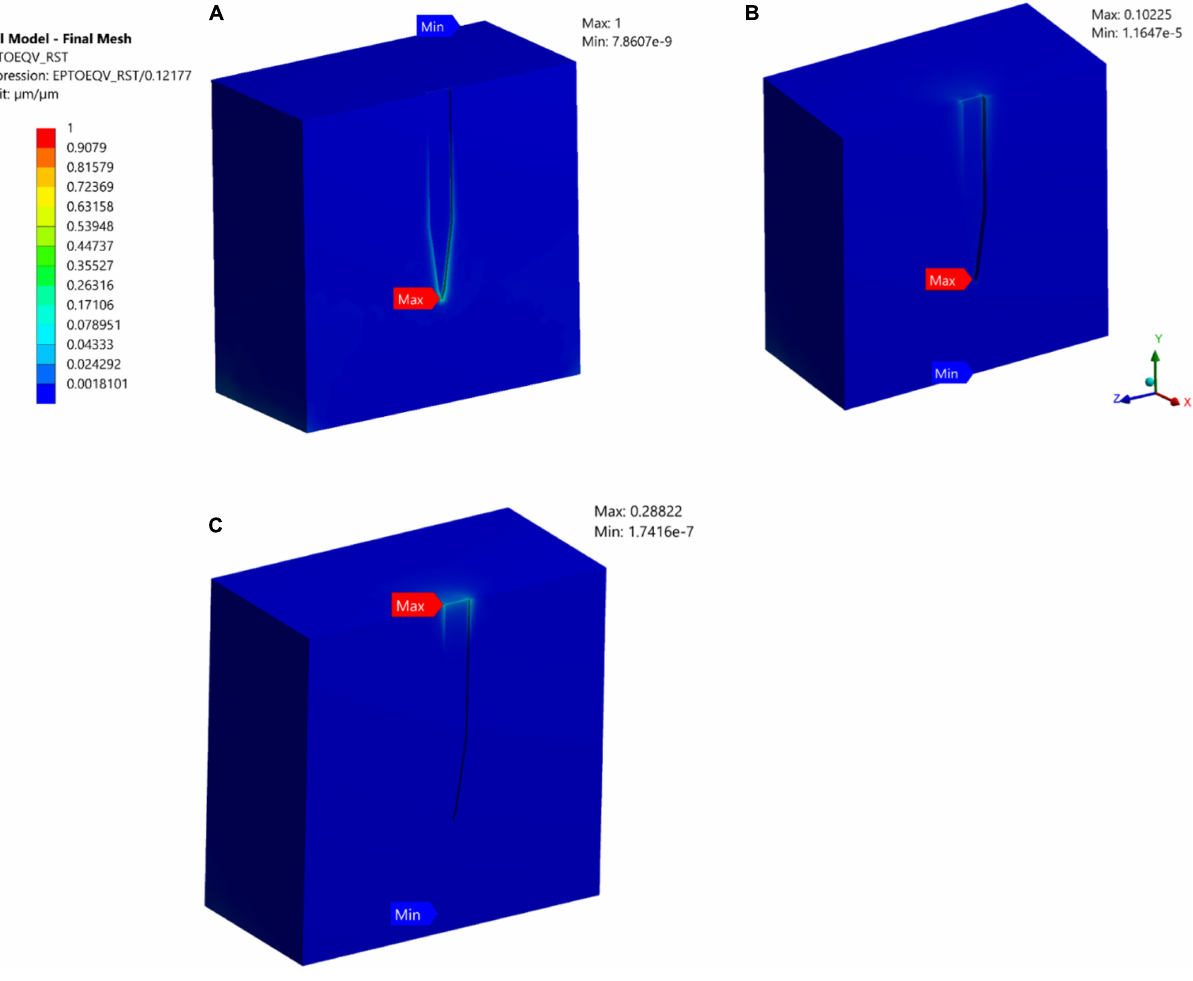
FIGURE 8 | Normalized strain distribution. (A) Stiff probe with thickness = 25 µ m – Case 1 in Table 1 ; (B) compliant probe with thickness = 63 µ m – Case 6 in Table 1 ; (C) compliant probe with thickness = 25 µ m – Case 7 in Table 1 . Strain distributions are normalized to the maximum induced strain surrounding the stiff probe of Case 1 in Table 1